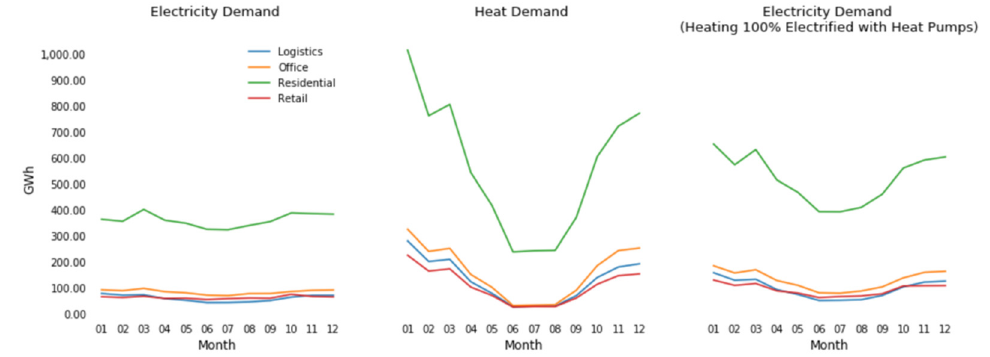
Figure 2. Electricity and heat demand in the Helsinki Metropolitan Area (HMA). Buildings have been grouped into four commonly used categories in property markets: logistics, office, residential, and